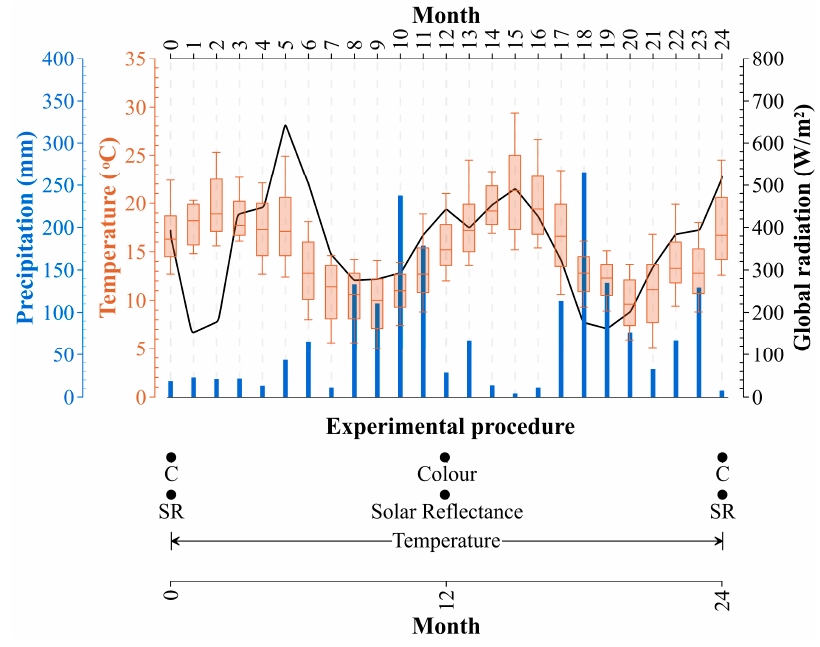
Figure 1. Timeline of the experimental procedure and climatic conditions (source: IPMA).